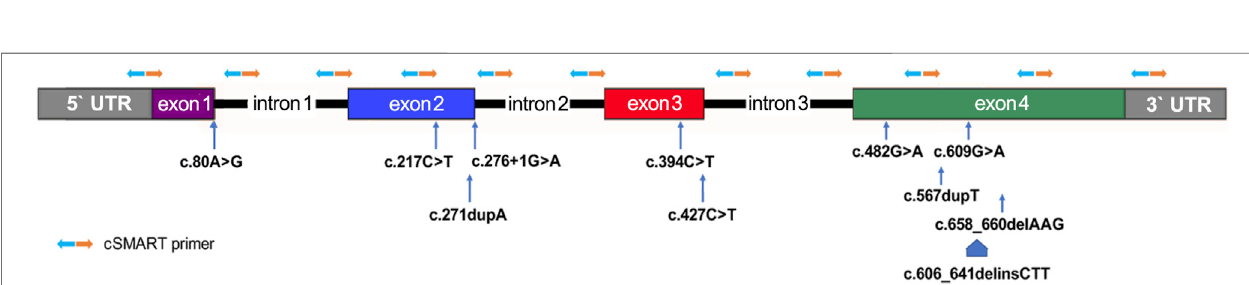
FIGURE 2 | Distribution of primers and known mutant alleles tested for the MMACHC gene in this study. Primer pairs for the inverse targeting PCR step of the cSMART assay are denoted by orange and blue arrows.